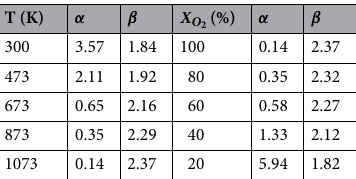
β 0 (a) varying T with 100%